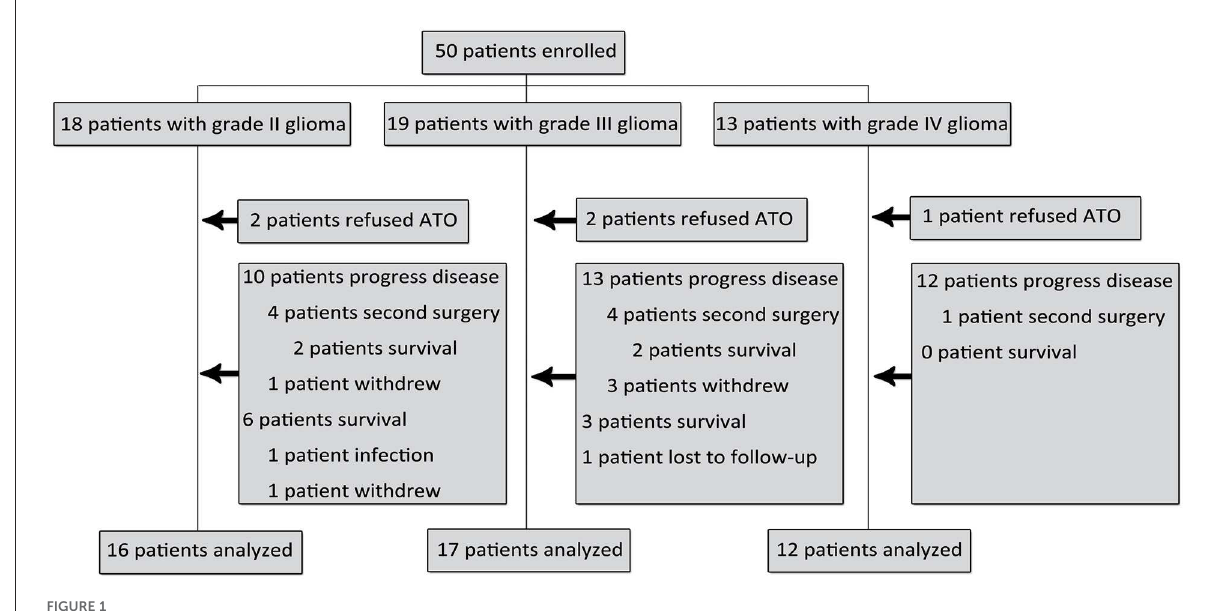
FIGURE1 Recruitment and inclusion of glioma patients in the study.